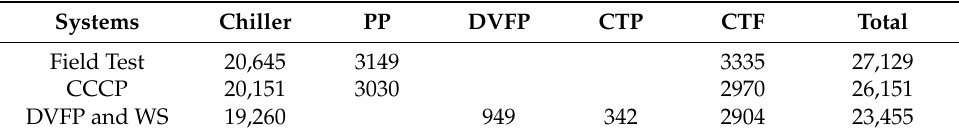
Figure 10. Total electric power for each system. Table 2. Summary of electricity consumption on a full-load day (kWh).